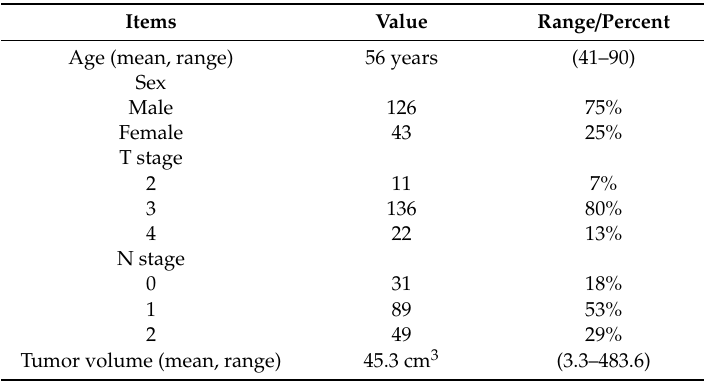
Table 1. Clinical data of the patient